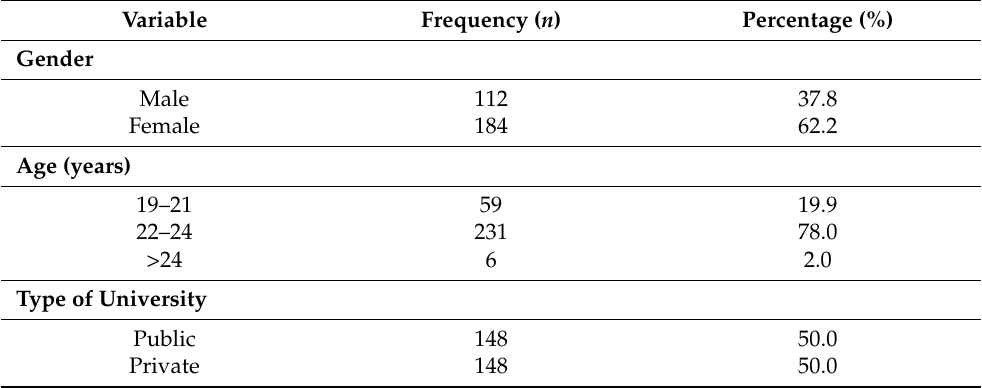
Table 1. Demographic characteristics of students ( n =